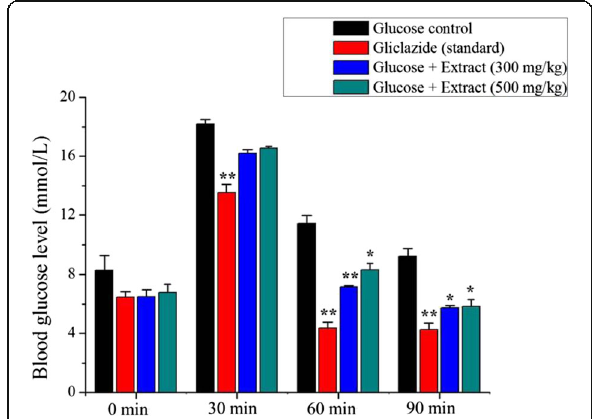
Fig. 7 Effect of C. crepidioides extract on OGTT. Values were represented as mean ± SD ( n = 6). * p < 0.05 and ** p < 0.01 as compared with the glucose control group